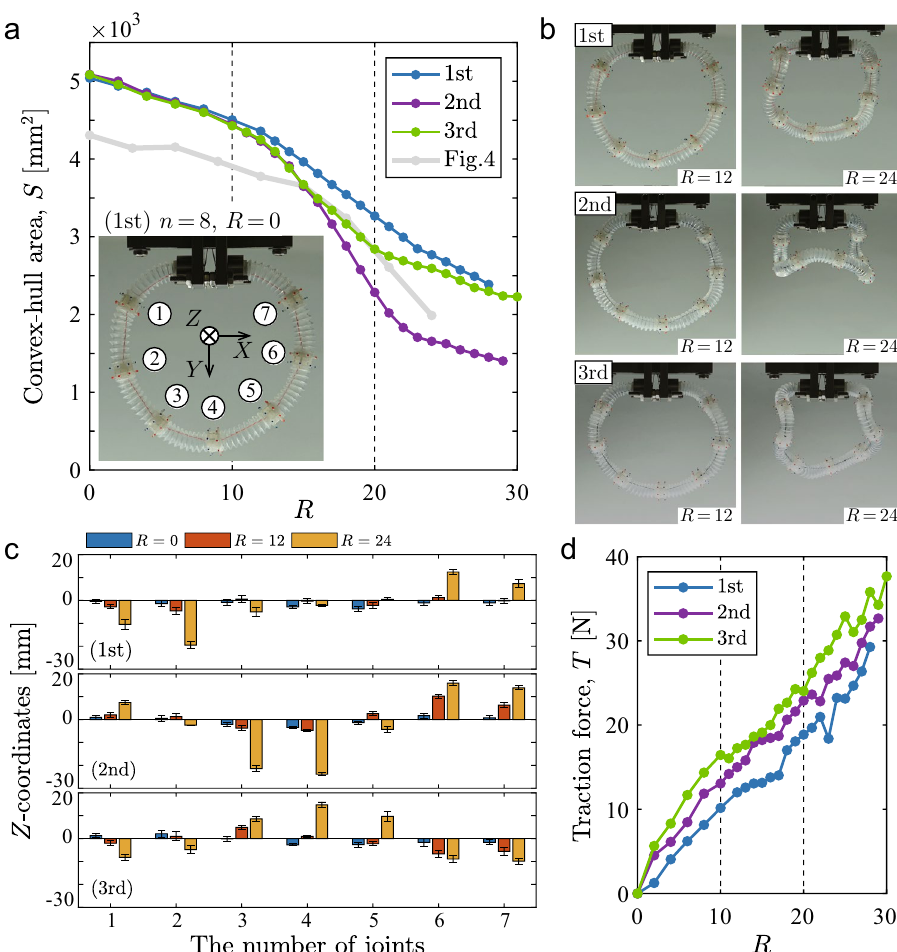
Figure 5. Results for the three loops with n = 8 : ( a ) changes in the convex-hull area, S ( R ); ( b ) deformation images at R = 12 and 24 in each test; ( c ) Z -coordinates of joints (blue, red, and yellow bars) at R = 0, 12 , and 24, where the numbers of joints are allocated in a counterclockwise manner from the fixed end [see inset in ( a )]; ( d ) changes in the force responses, T ( R